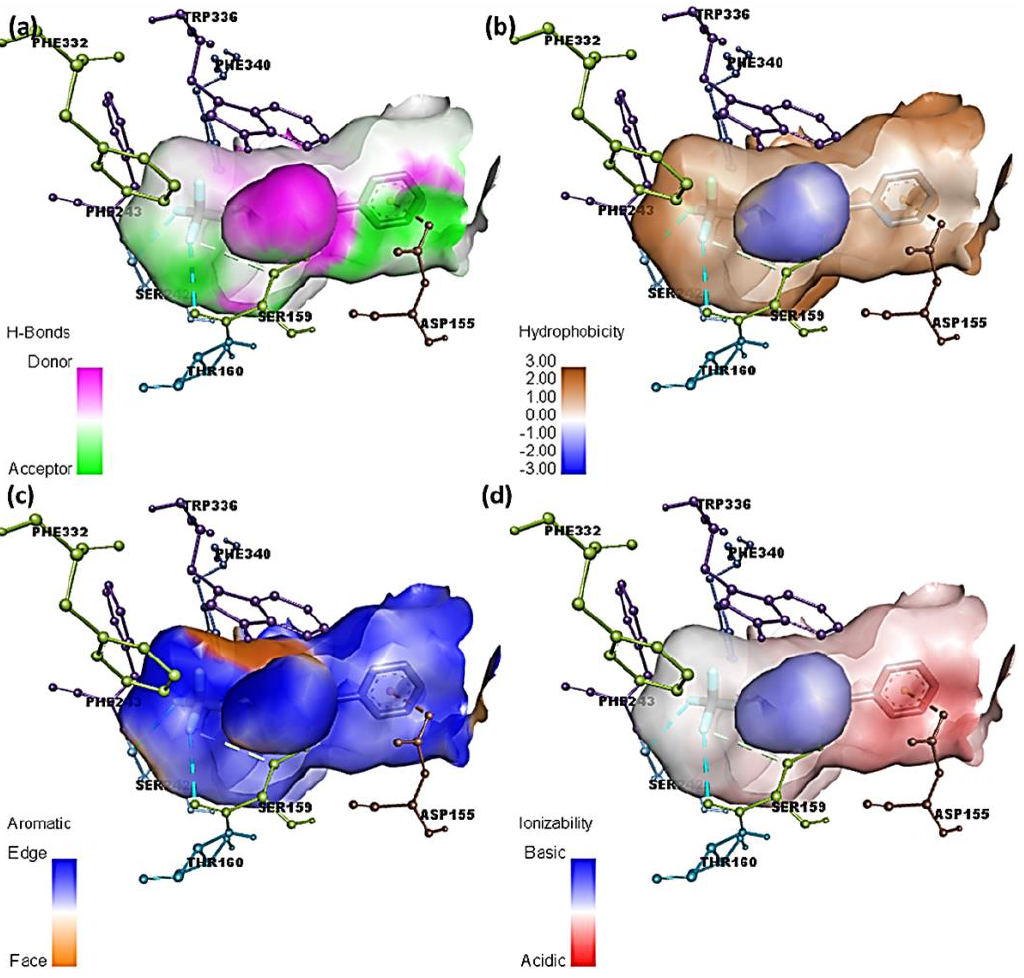
Figure 9. Molecular docking data of (FXN) – serotonin complex; ( a ) bonding surface of hydrogen bonds, ( b ) hydrophobic surfaces, ( c ) aromatic surface, and ( d ) ionizability surface.